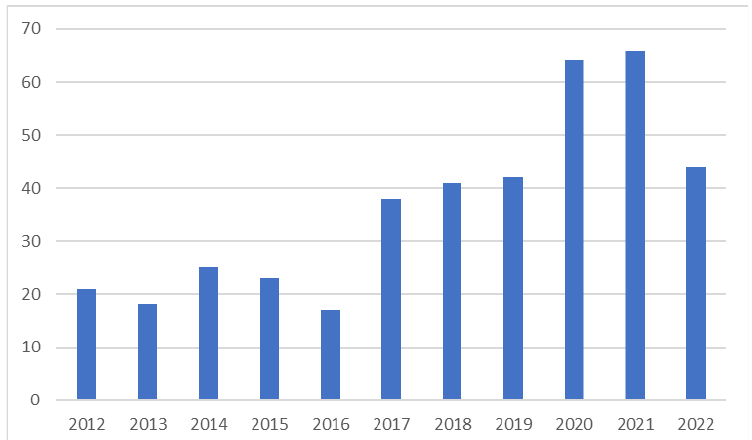
Figure 2. Year of publication of the